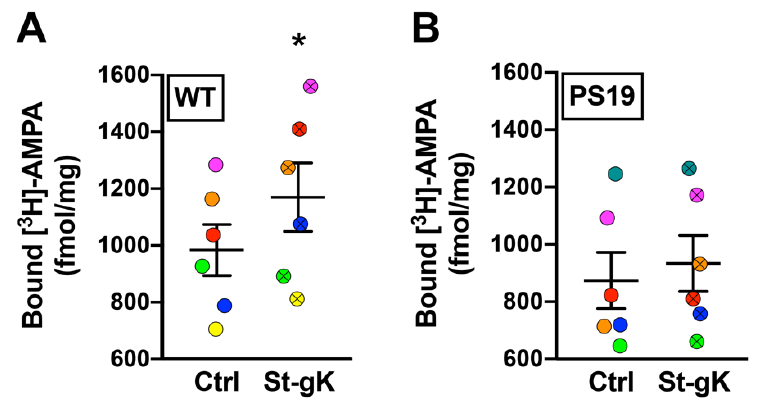
Figure 5. Chemically induced long-term potentiation (cLTP) is abolished in cortical synaptosomes of 8 months old PS19 mice. Surface AMPAR levels in cortical synaptosomes obtained from wildtype (WT) and PS19 mice were assessed following glycine priming and KCl stimulation (St-gK). A robust cLTP was induced in synaptosomes from WT mice ( A ), but not in PS19 mice ( B ). Results are expressed as mean (±SEM) bound [ 3 H]-AMPA ( n = 6 for each experiment). * represents a statistical significance at p < 0.05. The respective stimulated and unstimulated synaptosome pairs are color coded in each panel.